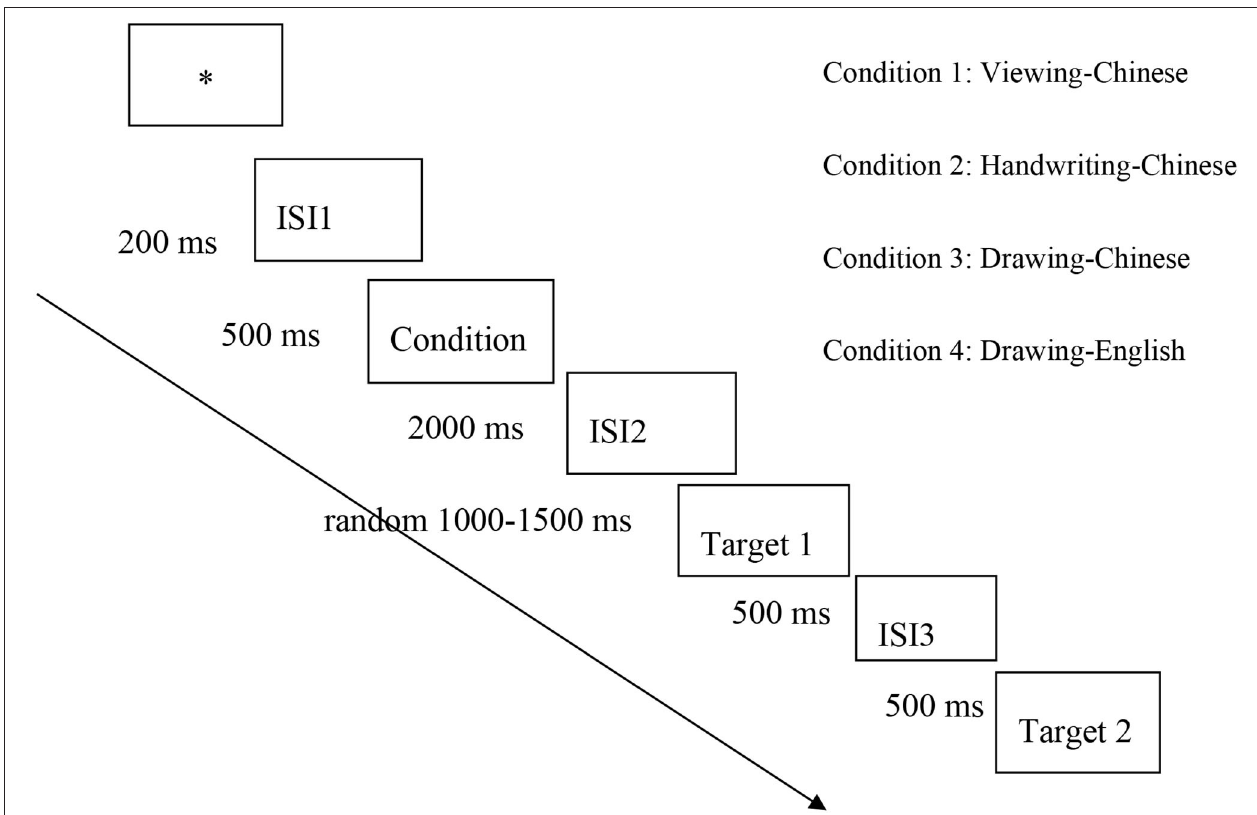
FIGURE 1 | Experimental procedure.